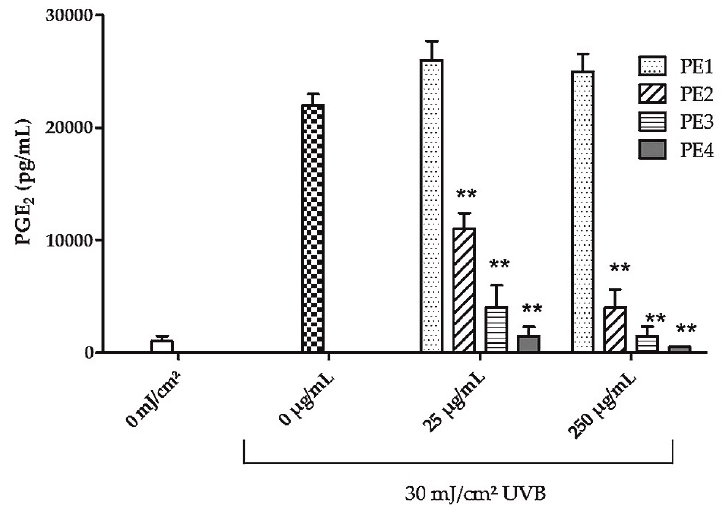
Figure 3. Effect of PE fractions on UVB-induced PGE 2 production in keratinocytes. After irradiation with 30 mJ/cm 2 HaCaT cells were treated for 24 h with PE1, PE2, PE3 or PE4 that were obtained by Sephadex LH20 column separation. The concentration of PGE 2 was measured in the cell culture supernatants. Data are expressed as mean ± SD of three independent experiments and the statistical significance was determined compared to the irradiated, untreated control (** p < 0.01).